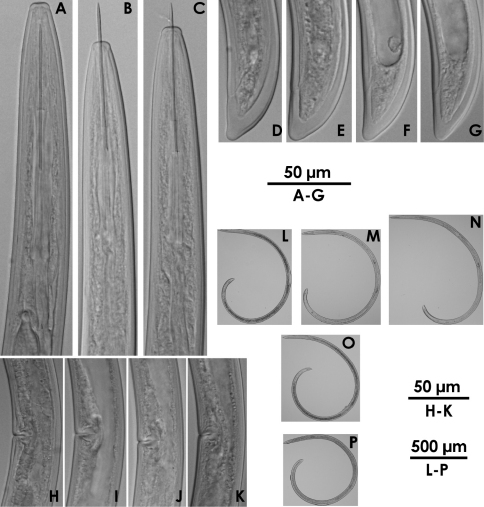
Xiphinema brevicolle (female) A–C Anterior region D–G Tail H–K Vulval region L–P Entire body.